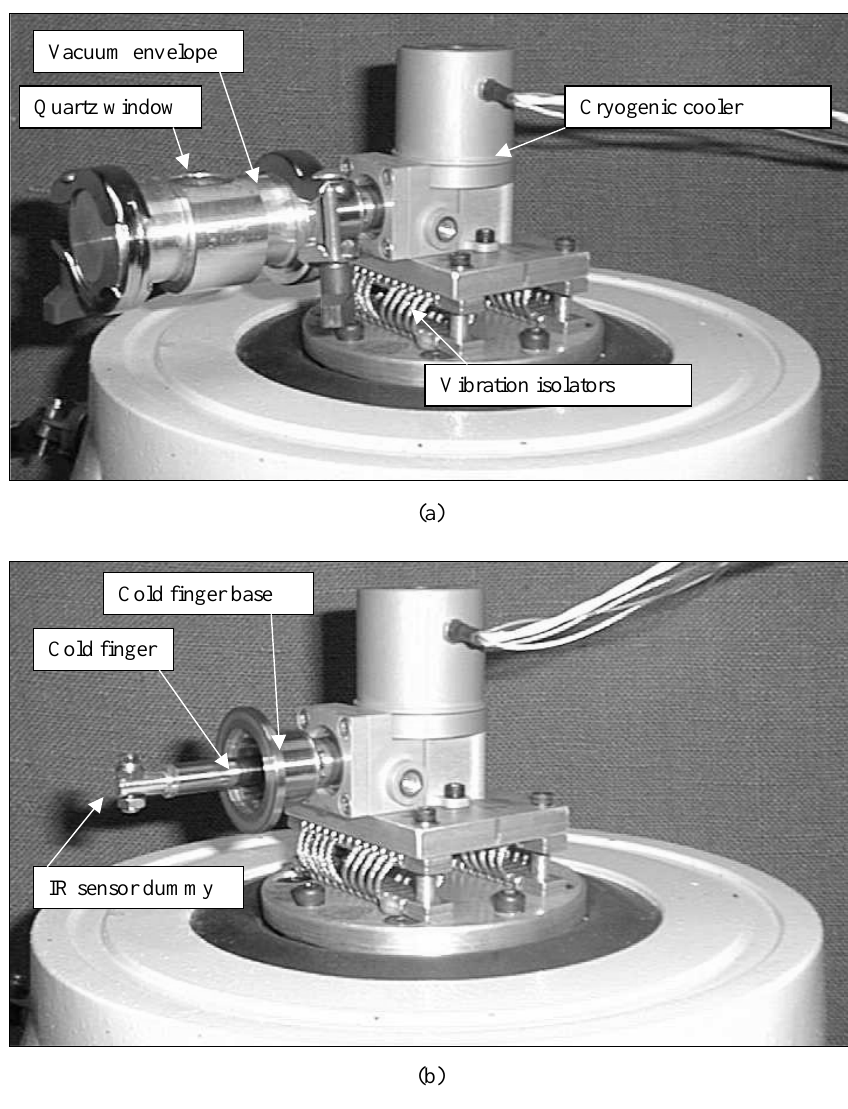
Fig. 15. Layout of experimental rig. Fig. 6. The cryogenic cooler is suspended from the vibration exciter table by means of two Shock Tech Cable Mounts (cid:1) 8 . Additional accelerometer and charge amplifiers are used for measuring the dynamic response of the cryo- genic cooler, which, in this case, is definitely different from the motion of the vibration exciter. During the ex- periments the vacuum envelope was mounted to cover the cold finger and measurements were taken through the transparent